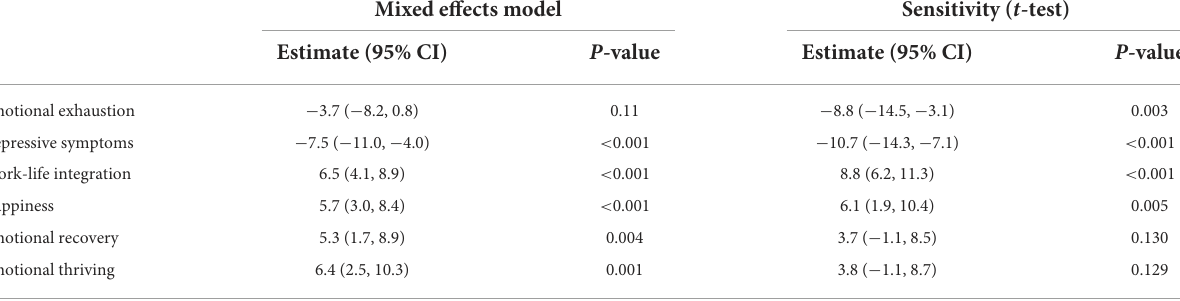
TABLE 2 Efficacy of WISER intervention at 1 week in mixed-effects model a and sensitivity analyses b